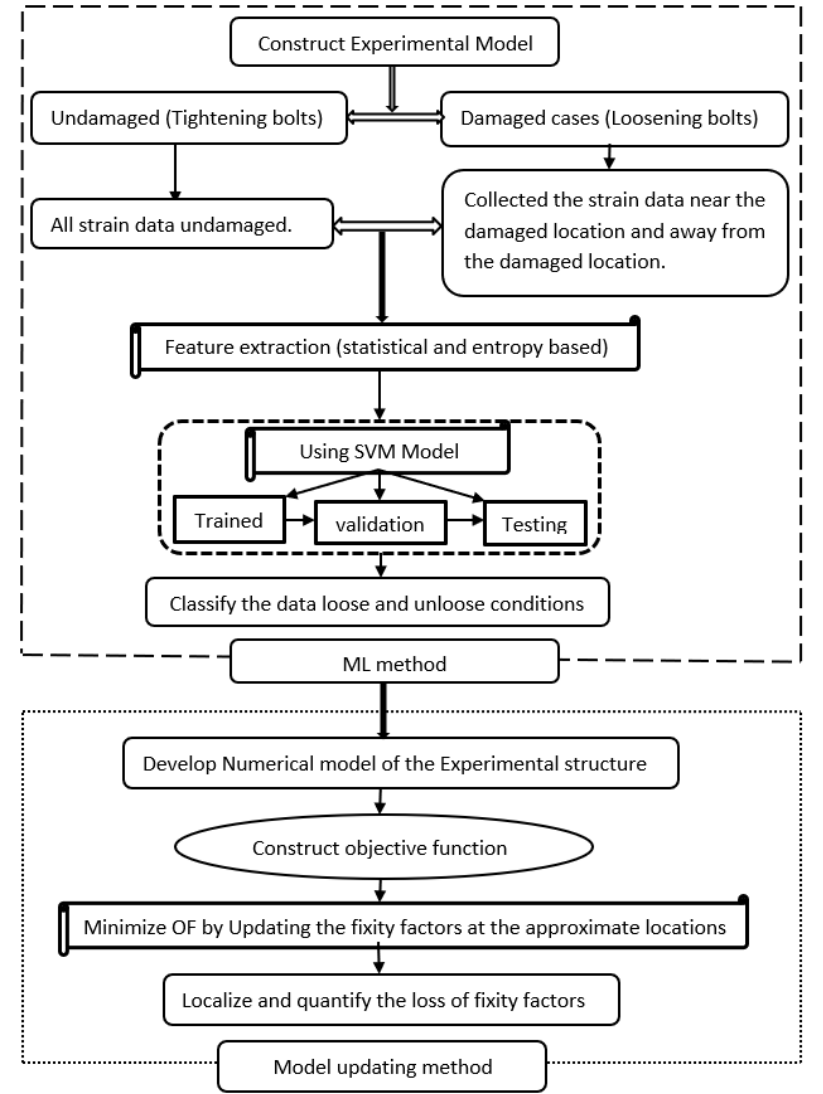
Figure 1. Working procedure of the hybrid ML and MU method.